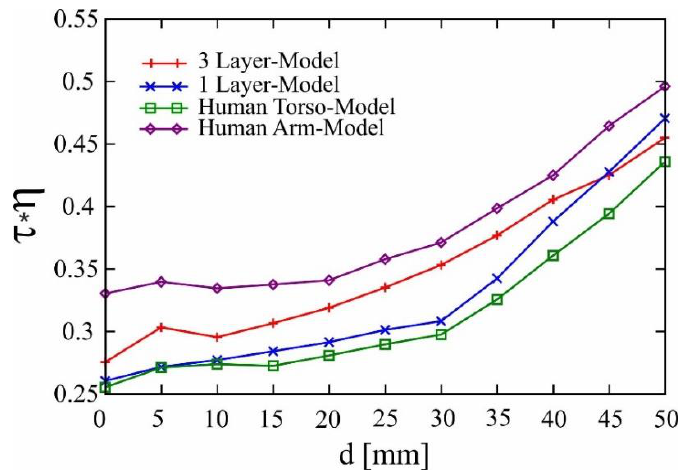
Figure 22. Variation of τ × η with respect to the distance from the body phantom for different body phantom models.